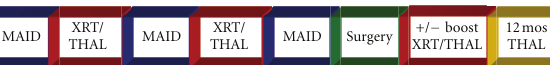
Figure 1: Treatment schema for RTOG 0330 cohort A. Neoadjuvant MAID (Mesna, Doxorubicin, Ifosfamide, DTIC) × 3 cycles, concur- rent thalidomide (THAL) and radiation therapy (XRT) × 2 cycles, followed by surgical resection, followed by adjuvant THAL for one year (post-op boost XRT if a positive